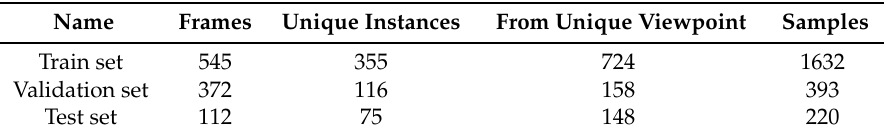
Table 1. Dataset